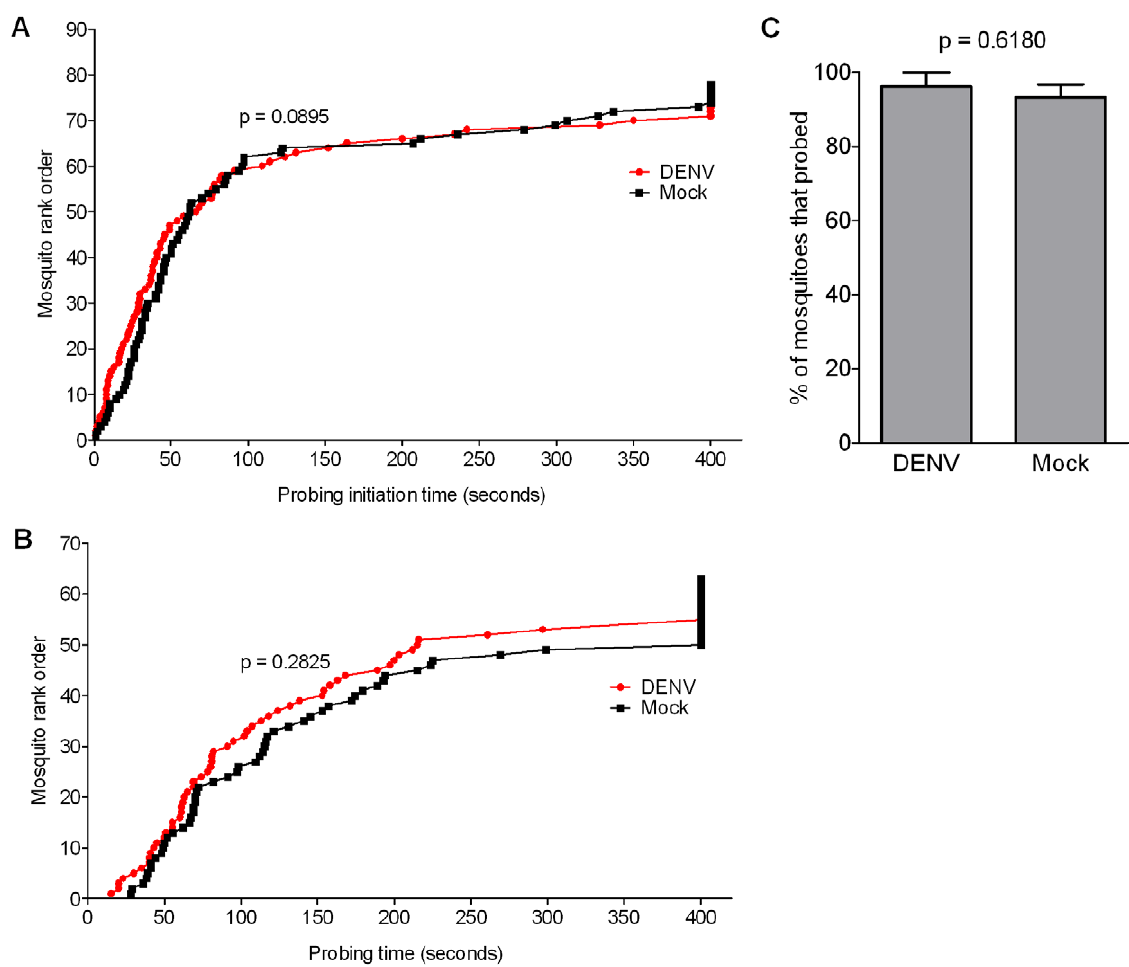
Figure 6. Effect of DENV infection on mosquito blood-feeding behavior. A behavioral feeding assay was performed on DENV- and mock- infected mosquitoes at 14 dpbm. Mosquitoes were offered an anesthetized mouse and observed for 400 seconds. The following parameters were measured and are represented here: ( A ) Probing initiation time; ( B ) Probing time; and ( C ) Probing propensity. The data are a pool of three biological replicates, and p values were determined with the Mann-Whitney U